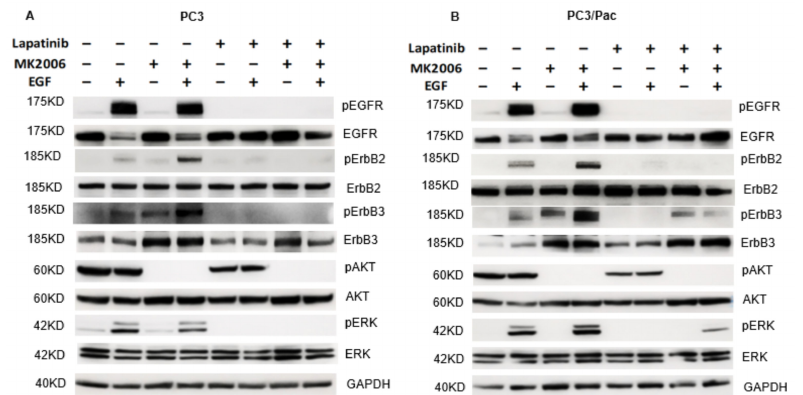
Figure 4. ErbB and downstream signaling in PC3 and PC3/Pac cells. Western blots. Cells were treated with DMSO, lapatinib (3 µ M), MK2206 (6 µ M) or both agents for 24 h, then they were indicated with EGF (50 ng/mL, 10 min) before the cell harvest was conducted. Forty-five ug protein samples were loaded per well. ( A ) PC3, and ( B ) PC3/Pac. The uncropped blots are shown in Figures S12 and S14.